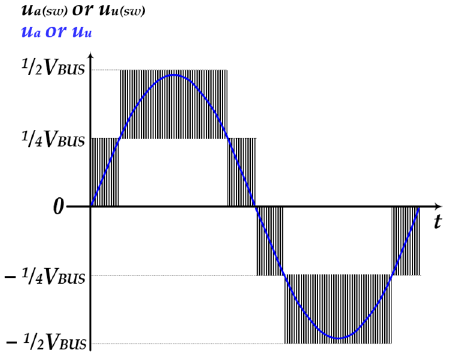
Figure 4. Phase-to-neutral switching voltage u a1(sw) (or u a2(sw) ).